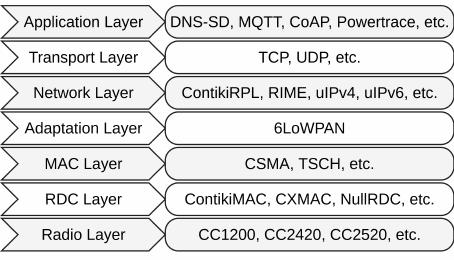
Figure 6. IoT-enabling protocols implemented in Contiki